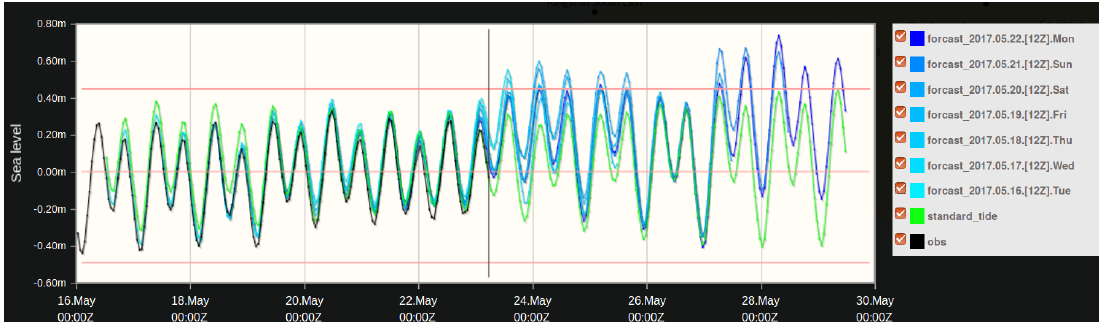
Figure 1. Illustrative sea level forecast for St Kilda at Melbourne, Australia. Sequential 7-day forecasts are shown overlaid in shades of blue. Observed sea level is shown in black and standard tide prediction in green. Red horizontal lines indicate conventional tidal planes LAT, MSL and HAT. Some spread is apparent between forecast updates. Sea level is not especially extreme, but is forecast to cross the reference HAT in coming